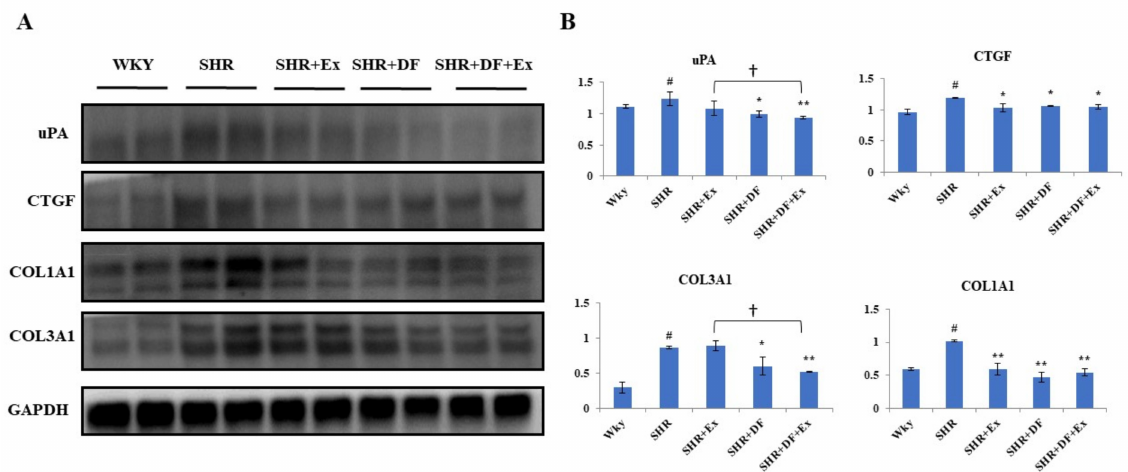
Figure 7. Effect of DF and exercise on the fibrosis-associated proteins in the heart tissue of SHR animals. ( A ) Expression of collagen type I α 1 chain, (COL1A1), COL3A1 CTGF, and tissue-type plasminogen activator protein uPA proteins. ( B ) Graph showing densitometric analysis. Each bar represents mean ± SD ( n = 8). # p < 0.01 compared to WKY, * p < 0.05 and ** p < 0.01 compared to SHR, † p < 0.05 compared to SHR +